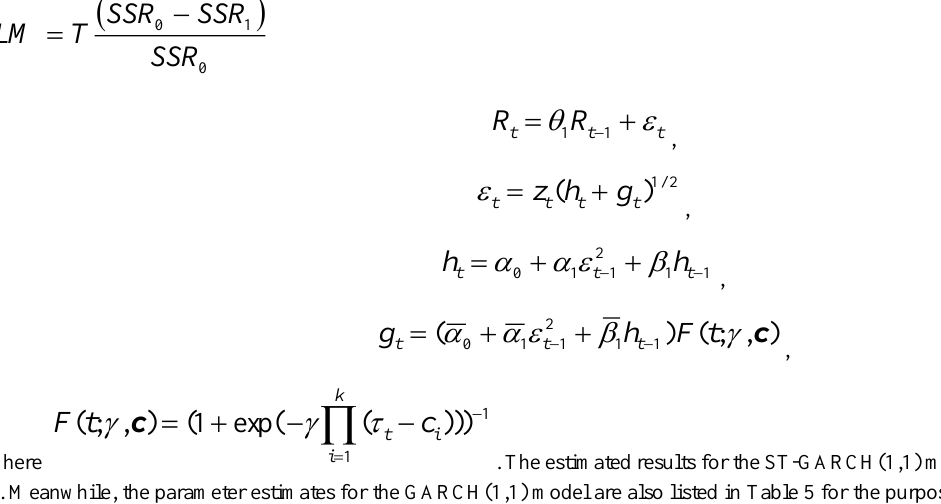
. The estimated results for the ST-GARCH(1,1) model are reported in Table 4. Meanwhile, the parameter estimates for the GARCH(1,1) model are also listed in Table 5 for the purpose of